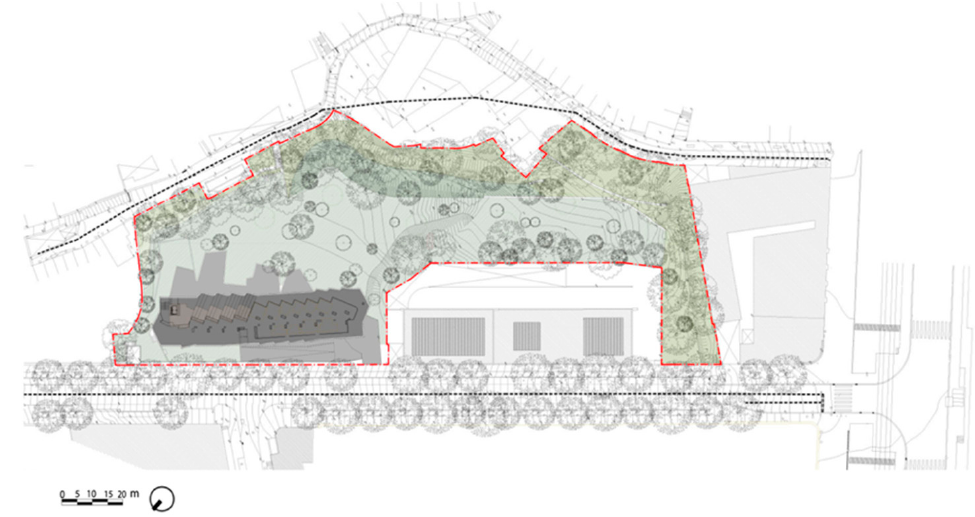
Figure 10. Porto. General plan.